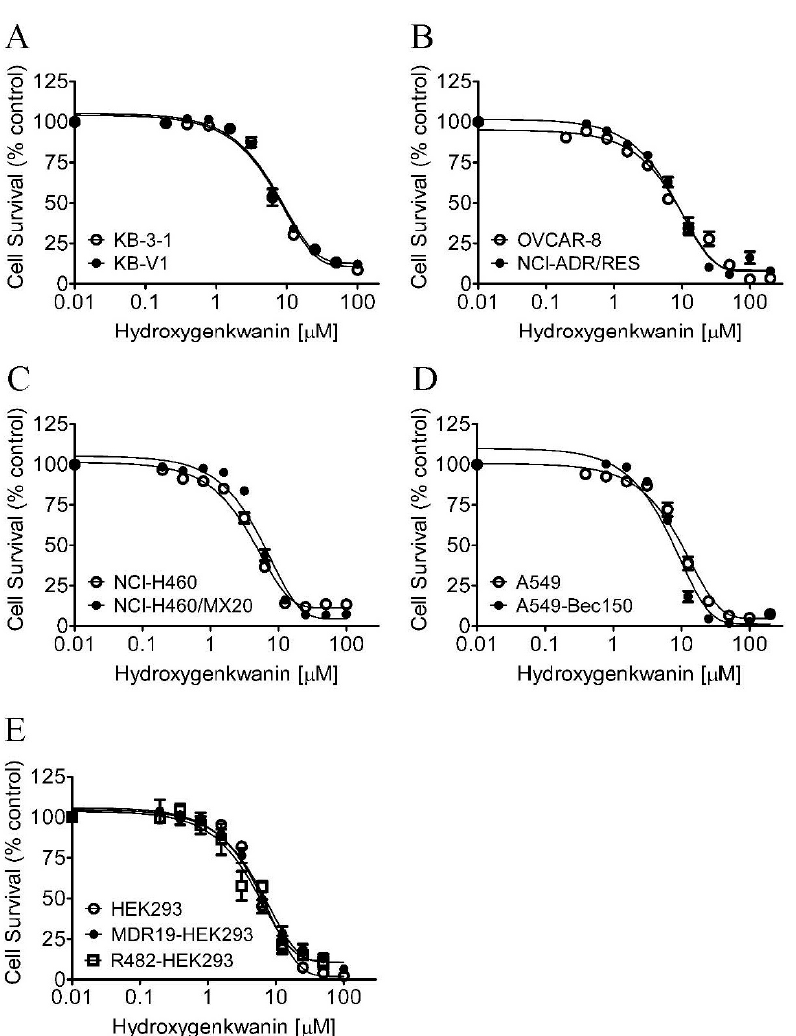
Figure 1. Intrinsic cytotoxicity of hydroxygenkwanin in normal and ABCB1- and ABCG2-overexpressing cell lines. The cytotoxicity of hydroxygenkwanin was determined in ( A ) the human epidermal cancer KB-3-1 cell line (empty circles) and its ABCB1-overexpressing subline KB-V1 (filled circles), ( B ) the human ovarian cancer OVCAR-8 cell line (empty circles) and its ABCB1-overexpressing subline NCI-ADR-RES (filled circles), ( C ) the human NSCLC NCI-H460 cell line (empty circles) and its ABCG2-overexpressing subline NCI-H460/MX20 (filled circles), ( D ) the human NSCLC A549 cell line (empty circles) and its ABCG2-overexpressing subline A549-Bec150 (filled circles), as well as in ( E ), the parental pcDNA3.1-HEK293 (empty circles), MDR19-HEK293 (HEK293 cells transfected with human ABCB1, filled circles), and R482-HEK293 (HEK293 cells transfected with human ABCG2, empty squares) cell lines. Points: mean values from at least three independent experiments; bars: